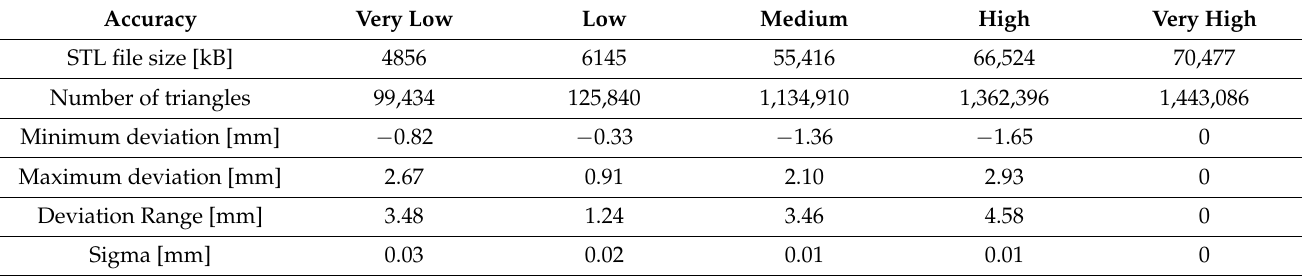
Figure 3. Comparison of tessellated cellular structures models of various accuracies with the nominal CAD model in GOM Inspect. ( a ) model Very Low, ( b ) model Low, ( c ) model Medium, ( d ) model High, and ( e ) model Very High. Table 1. Table of values obtained from the comparison of cellular structure models of various accuracies and the nominal CAD model in GOM